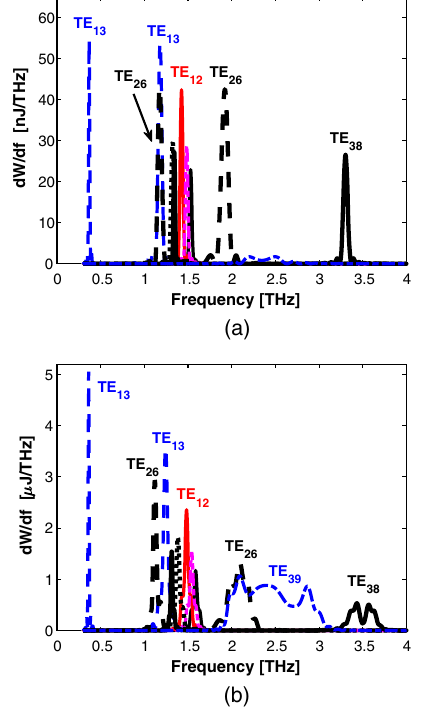
FIG. 2. Radiation spectra of the dominant modes radiated by a pointlike charge of 1 pC (a) and 10 pC (b) in a helical undulator with over-resonance guiding field B 0 ¼ 75 kG and oversized waveguide at the first three undulator harmonics after N u ¼ 40 undulator